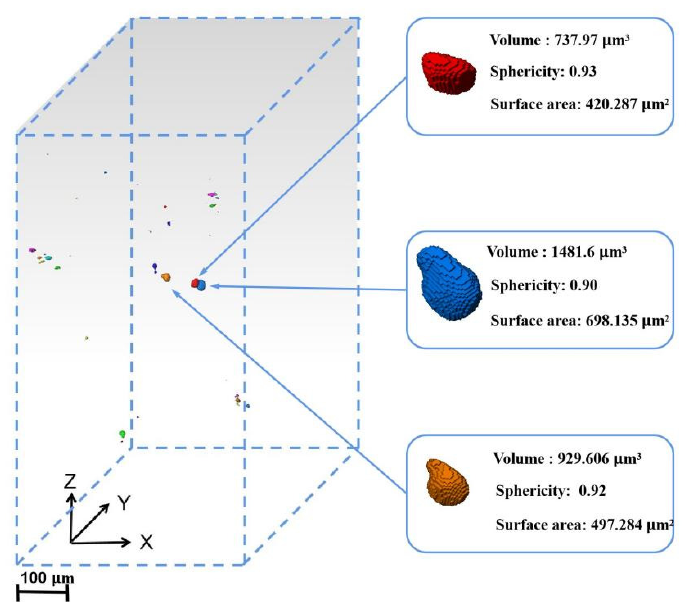
Figure 9. SR- μ CT imaging area reconstruction showing representative defects in the micro sample.